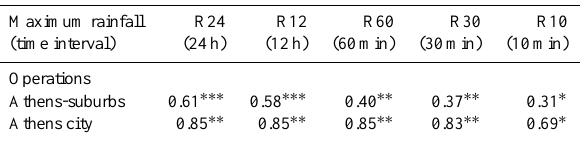
Figure 6. Monthly distribution of the number of flash flood events that occurred in the Athens-suburbs region and fire service opera- tions. Table 2. Correlation (Spearman’s rank coefficient, ρ ) between the number of the fire service operations and the maximum rainfall in various time